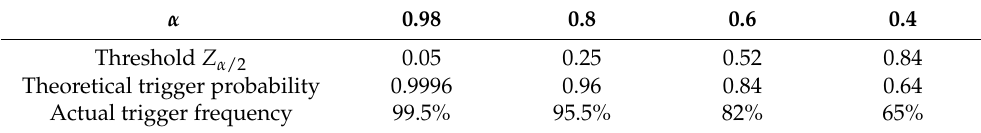
Table 3. Comparison of trigger frequency in the time-varying system under different α values.